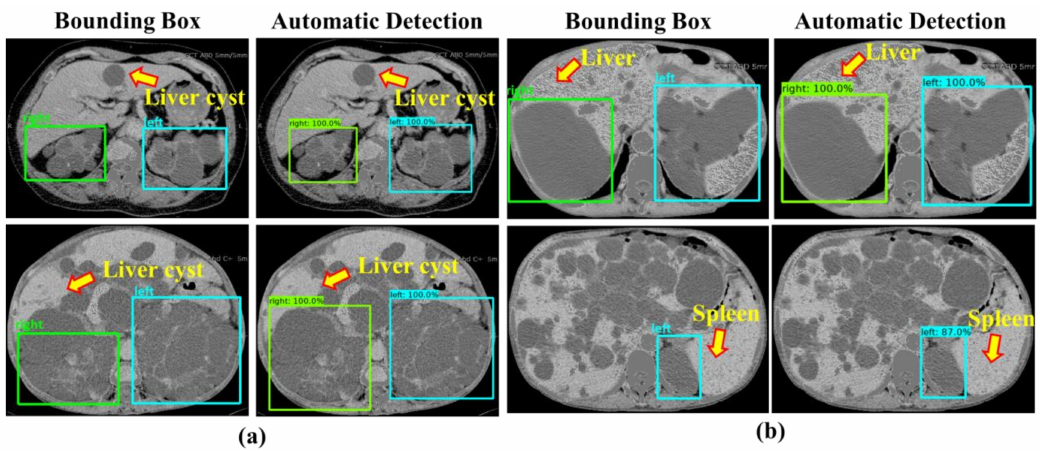
Figure 8. Detection results: ( a ) ADPKD kidneys associated with liver cysts; ( b ) ADPKD kidneys with adjacent organs.